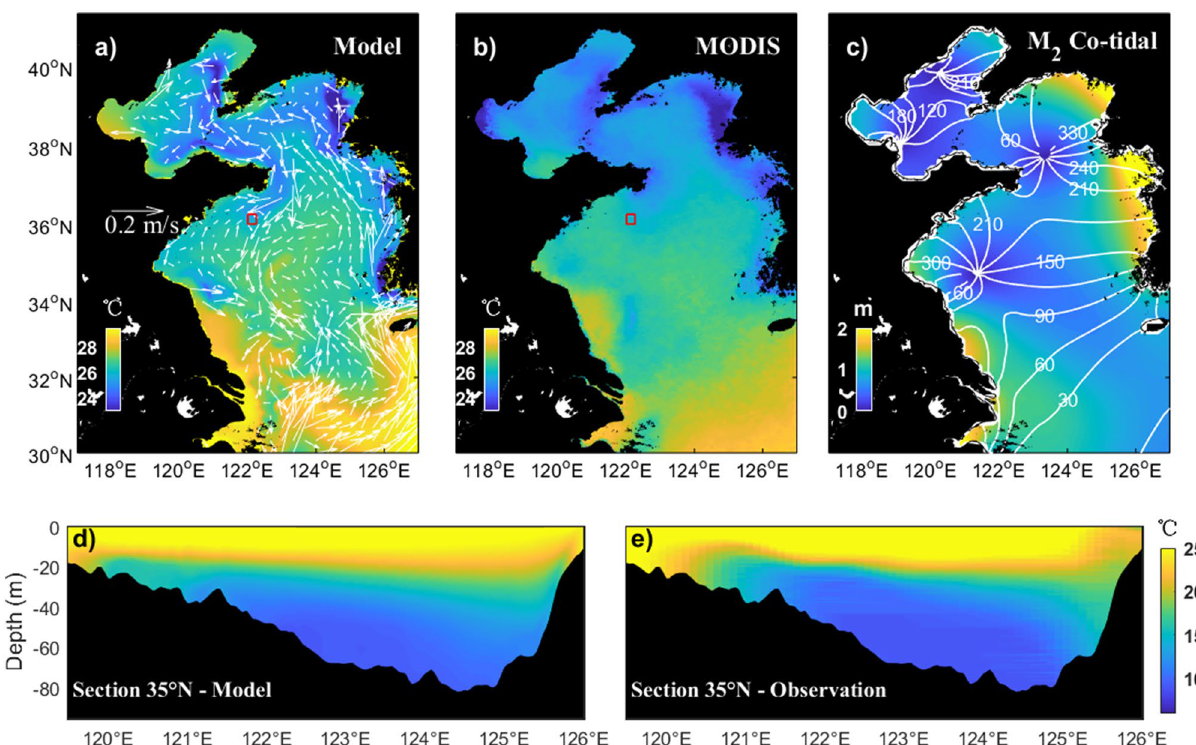
Figure 2. Temperature validation between the monthly-mean climatology (Aug) simulations and observations. ( a , b ) Comparison of the sea surface temperature between the model results and MODIS data. The red box indicates the location of the target region. The simulated current field at the depth of 10 m is also shown in ( a ). ( c ) M 2 barotropic cotidal chart with amplitude (colors) and cophase (white lines) lines. (d , e) Comparison of the along section (35°N) temperature between the model results and the observations redrawn from the Atlas of Ocean Data in the China Seas. Figures are plotted using MATLAB R2017a (http:// www. mathw orks. com/) with M_Map v1.4 (a mapping package, http:// www. eos. ubc. ca/ ~rich/ map.